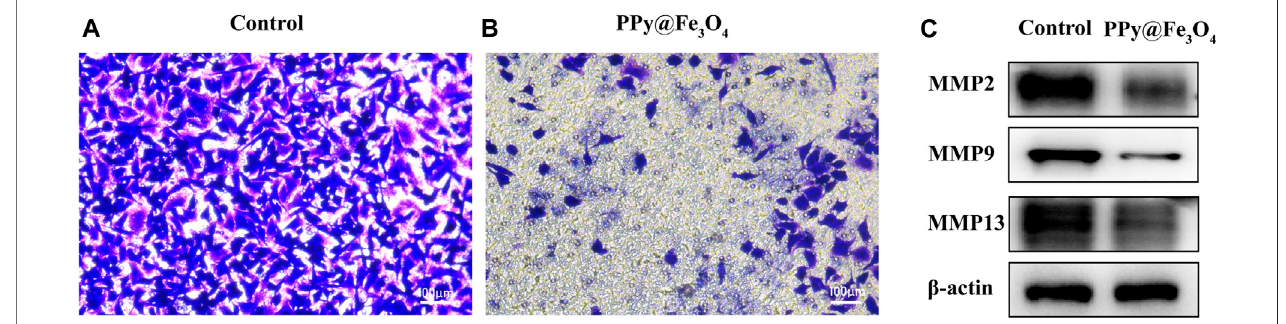
FIGURE5| ThePPy@Fe 3 O 4 NPsinhibitthemigrationofhumanlungcancercells. (A,B) ThemigrationcapacityofA549cellsmeasuredusingtranswellassaysafter PPy@Fe 3 O 4 NPs (400 μ g/ml) treatment for 48 h. Scale bar, 100 μ m. (C) Protein levels of MMP2/MMP9/MMP13 in different groups.